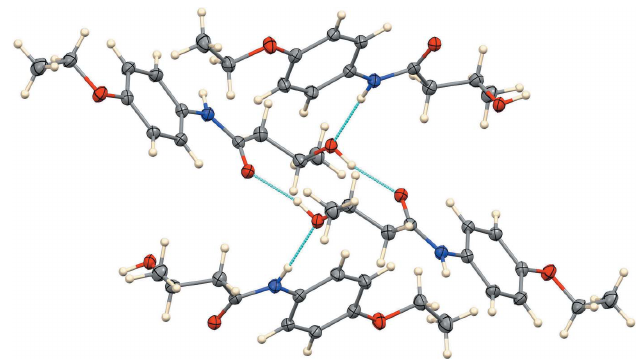
Figure 2 The hydrogen bonding in the packing of N -(4-ethoxyphenyl)-3-hydroxy- butanamide.